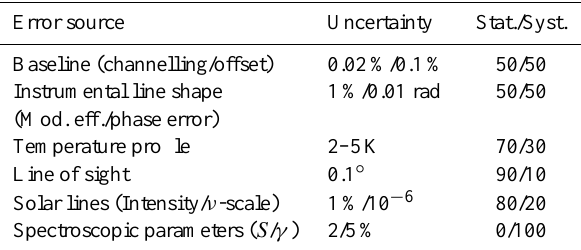
Table 3. Statistical and systematic errors in the Karlsruhe total CO 2 -column due to the assumed uncertainty sources of Table 2. The total error represents the root-sum-squares of all errors.